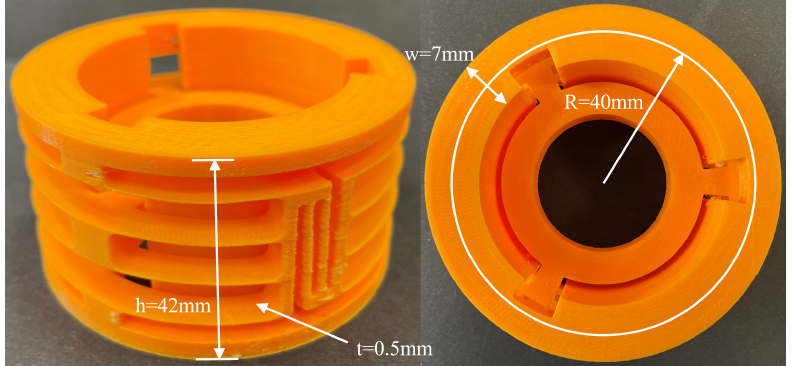
Figure 9. The side view and top view of the printed decoupled compliant